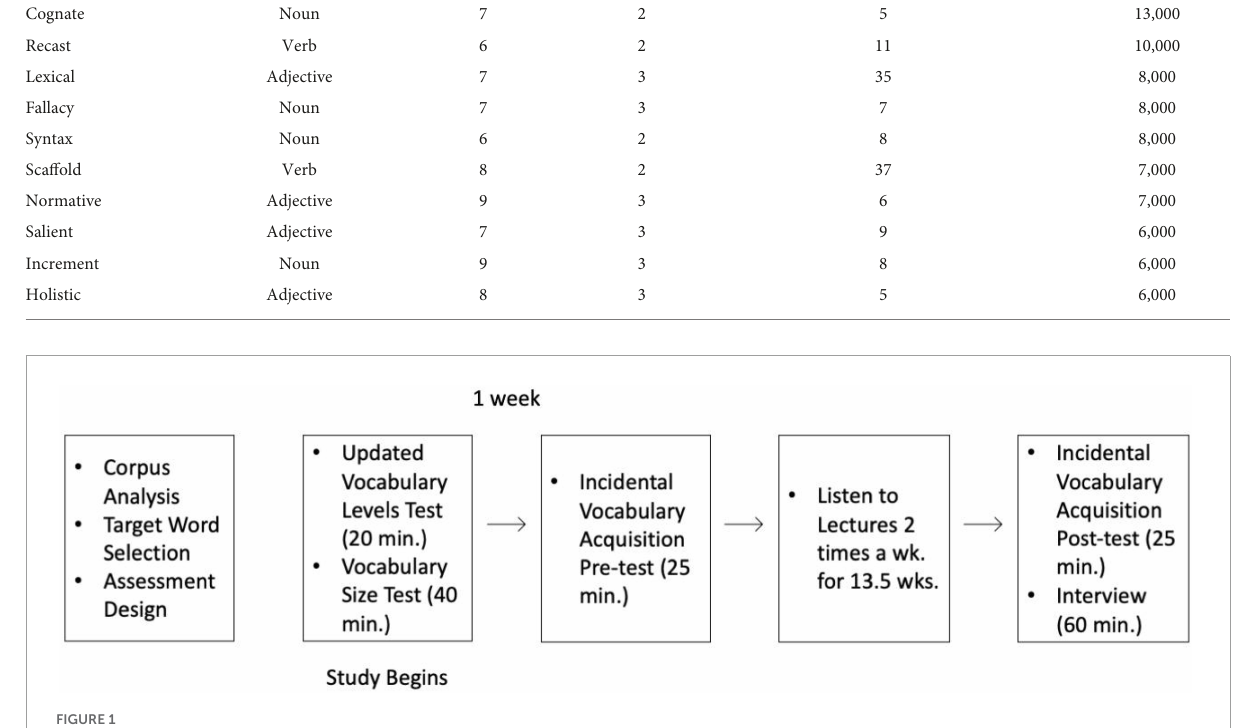
FIGURE1 Research